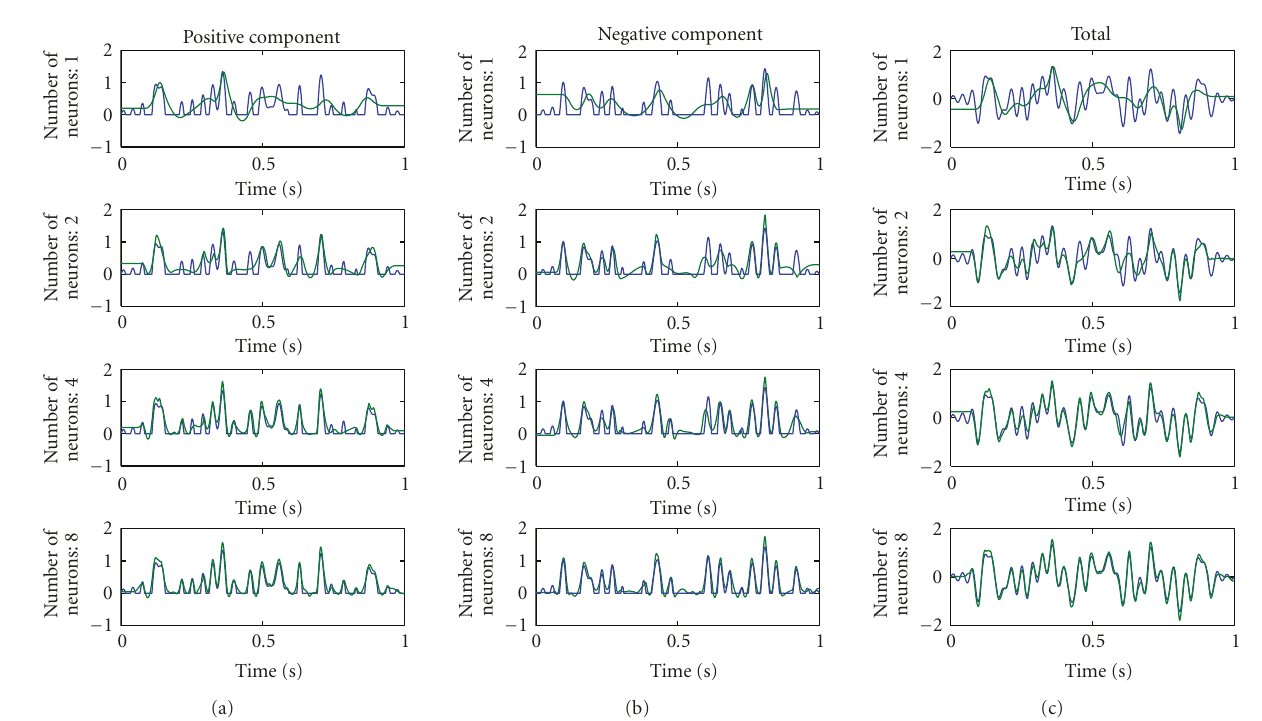
Figure 7: Recovery of absolutely continuous stimuli encoded with a population of LIF neurons with random thresholds.